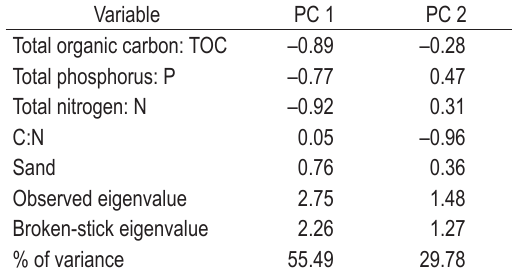
Figure 5. Trophic State Index (TSI) according to Lamparelli (2004) based on the average of chorophyll- a and total phosphorus for the Billings Complex (RG: Rio Grande Reservoir, RP: Rio Pequeno branch, CB: Central body, TQ: Taquacetuba branch). Values refer to winter (2009), summer (2010) and the annual Table 3. Loadings of limnological variables on the first Table 4. Loadings of geochemical variables on the first two principal components (PC) and the proportion of two principal components (PC) and the proportion of variance explained by each component. variance explained by each component.